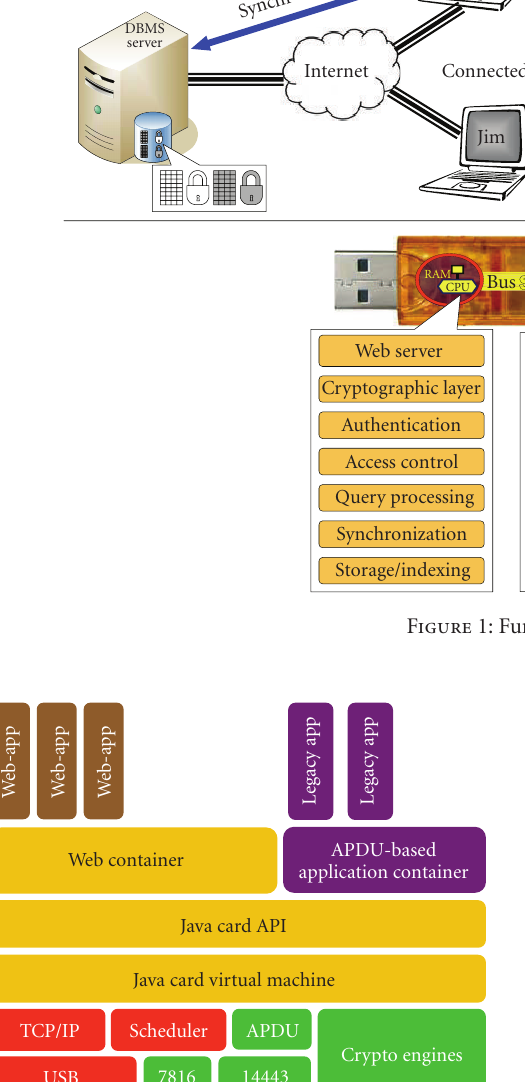
Figure 2: SPT system